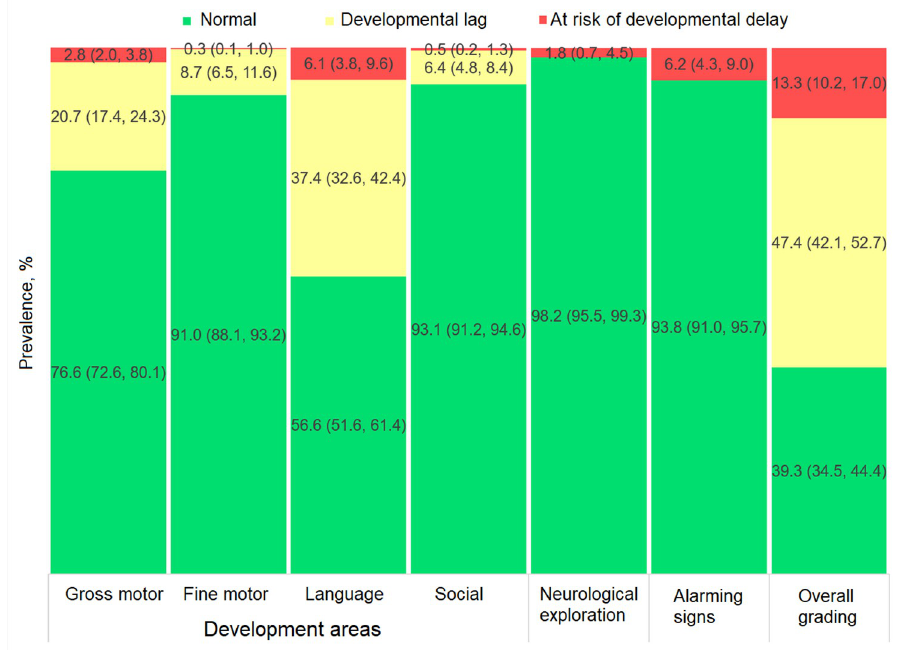
PLOS ONE | https://doi.org/10.1371/journal.pone.0270085 June 21,